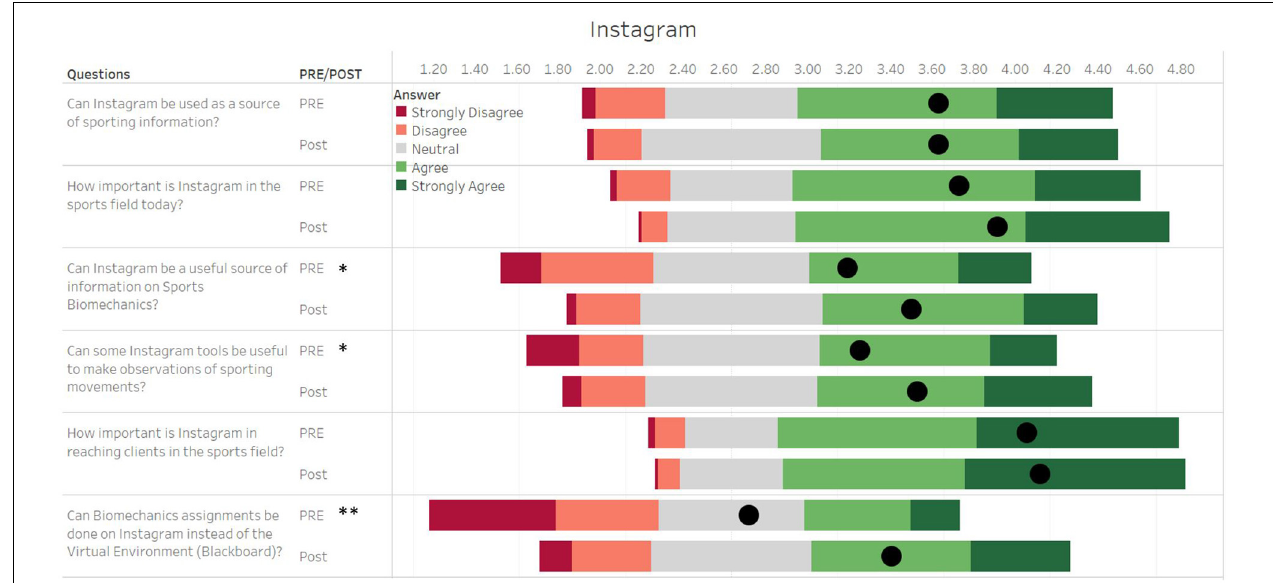
FIGURE 5 | Student responses for questions in the survey related to Instagram. The length of each bar of the Gantt chart represents the number of corresponding responses before (PRE) and after (Post) activity, with the black dot representing the average of all values. The responses were recorded on a five-point Likert-type scale, where 1 represented a strong disagreement with the question and 5 represented a complete agreement to the question. * Represents a significant difference between pre- and post-values at p < 0.05. ** Represents a significant difference between pre- and post-values at p <